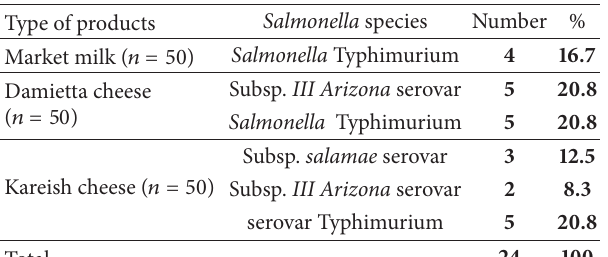
Table 1: Prevalence of Salmonella serovars among milk and dairy